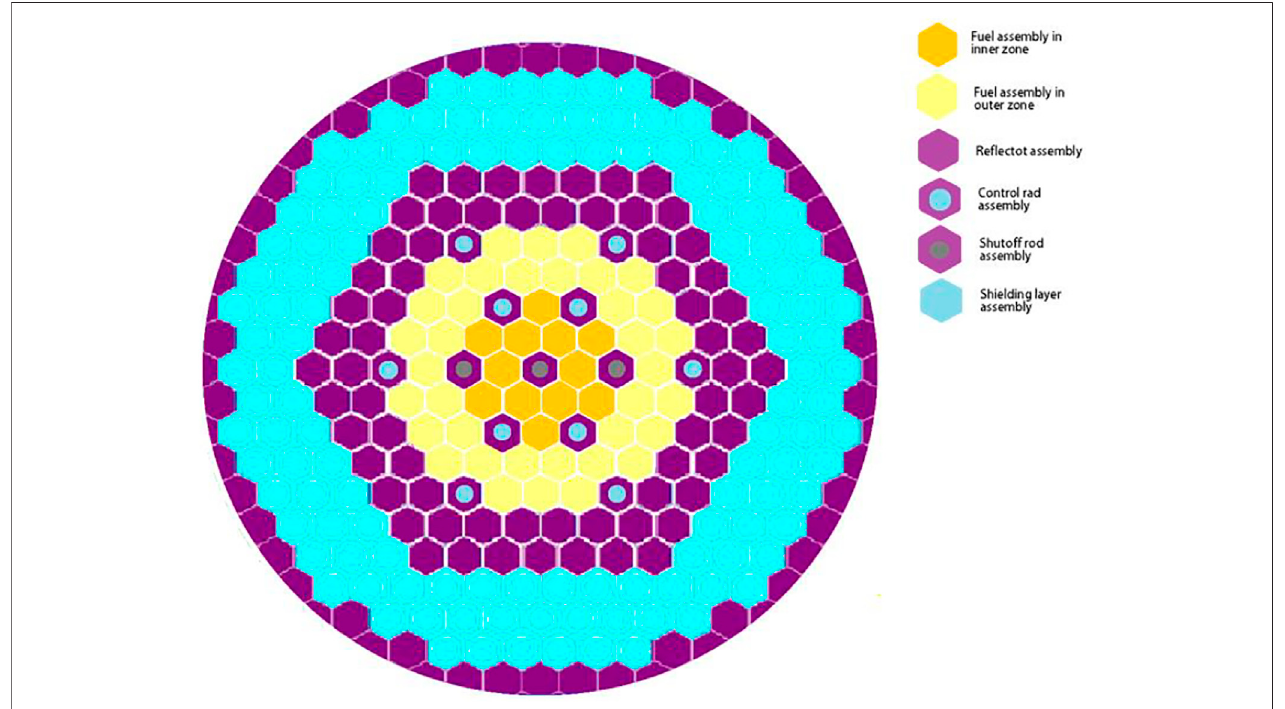
FIGURE 6 | Cross-sectional schematic diagram of SPALLER-100 core.